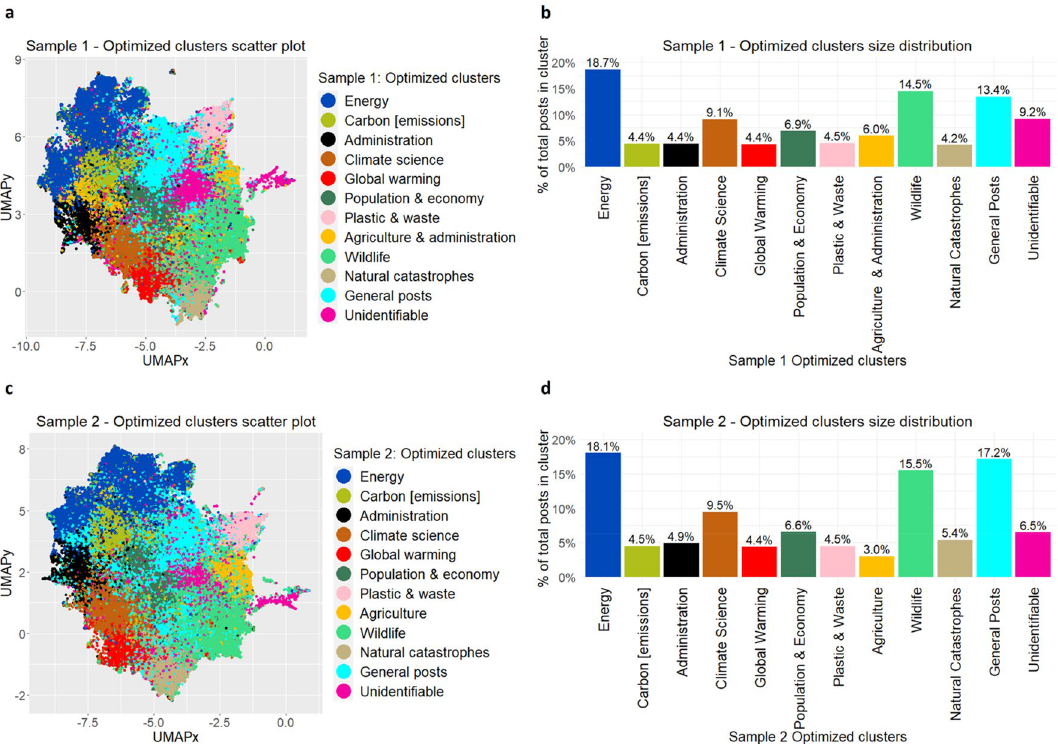
Figure 4. Final optimized clusters. Shown here are the final optimized clusters obtained for both Sample 1 ( a , b ) and Sample 2 ( c , d ). On left hand side are the scatter plots visualized using UMAP model, by projecting the 512D USE feature vectors on a 2D space using two UMAP components denoted as UMAPx and UMAPy representing the x-axis and y-axis of the scatter plots, with different colours representing the unique optimized clusters for Sample 1 ( a ) and Sample 2 ( c ). On the right-hand side are the size distribution column charts for the same optimized clusters with corresponding colours showing the percentage of total number of Reddit posts contained within those clusters obtained from Sample 1 ( b ) and Sample 2 ( d